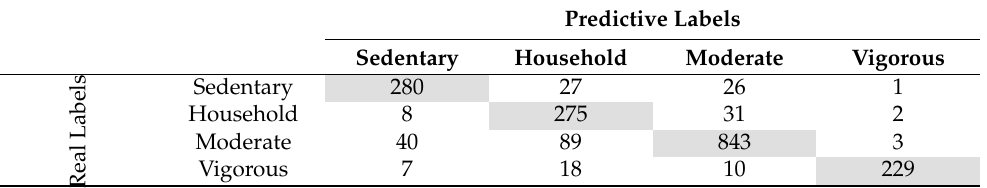
Figure 6. Classification results aimed at the four activity intensity labels among these three machine learning algorithms. Table 3. The Confusion matrix of the four activity intensity labels among the KNN algorithm.